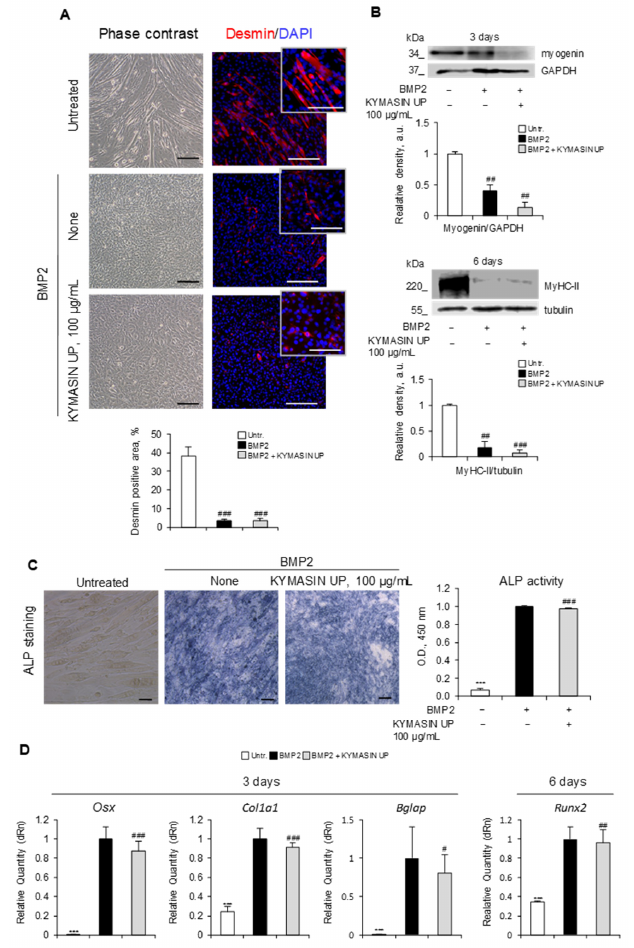
Figure 4. ( A – D ) C2C12 cells were treated with BMP2 (bone morphogenetic protein 2) with or without KYMASIN UP (100 µg/mL) for 3 or 6 days. ( A ) Phase-contrast images and immunofluorescence staining for the myogenic marker, desmin (red), were performed after 6 days of culture. DAPI (4 ′ ,6-diamidino-2-phenylindole, blue) was used to stain nuclei. The percentages of desmin-positive areas were evaluated. ( B ) The expressions of the late markers of myogenic differentiation, myogenin and MyHC-II (adult isoform II of myosin heavy chain), were analyzed by Western blotting at 3 or 6 days, respectively. Reported are the relative densities with respect to GAPDH or tubulin. ( C ) ALP (alkaline phosphatase) staining was performed, and ALP activity was measured by ELISA. ( D ) Real-time PCR analysis of the osteoblast (OB) markers, Osx (Sp7 transcription factor, Osterix), Col1a1 (collagen type I alpha 1 chain), Bglap (bone gamma-carboxyglutamate protein), and Runx2 (RUNX family transcription factor 2) was performed after 3 or 6 days of treatment. Gene expressions were normalized to Gapdh . Results are means ± standard error of the mean ( A , C ) or standard deviation ( B , D ). Three independent experiments were performed ( A – D ). Statistical analysis was conducted using the two-tailed t -test. *** p < 0.001, significantly different from BMP2. # p < 0.05, ## p < 0.01, and ### p < 0.001, significantly different from untreated control (Untr). Reported are representative images ( A – C ). Scale bars, 200 µ m ( A , C ) or 100 µ m (insets in ( A